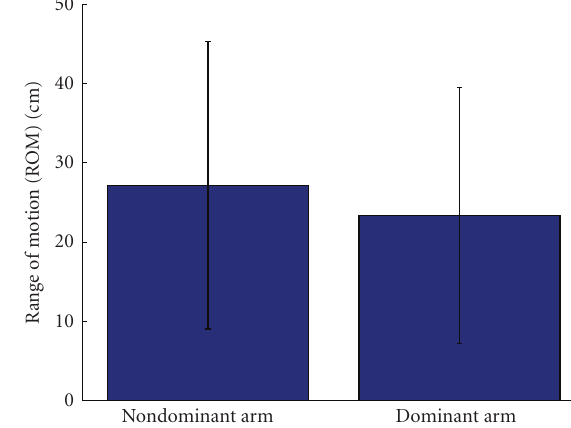
Figure 7: Arm displacement on the tabletop (cm) per item collected during a NTT training session. Data from healthy participant number 1.